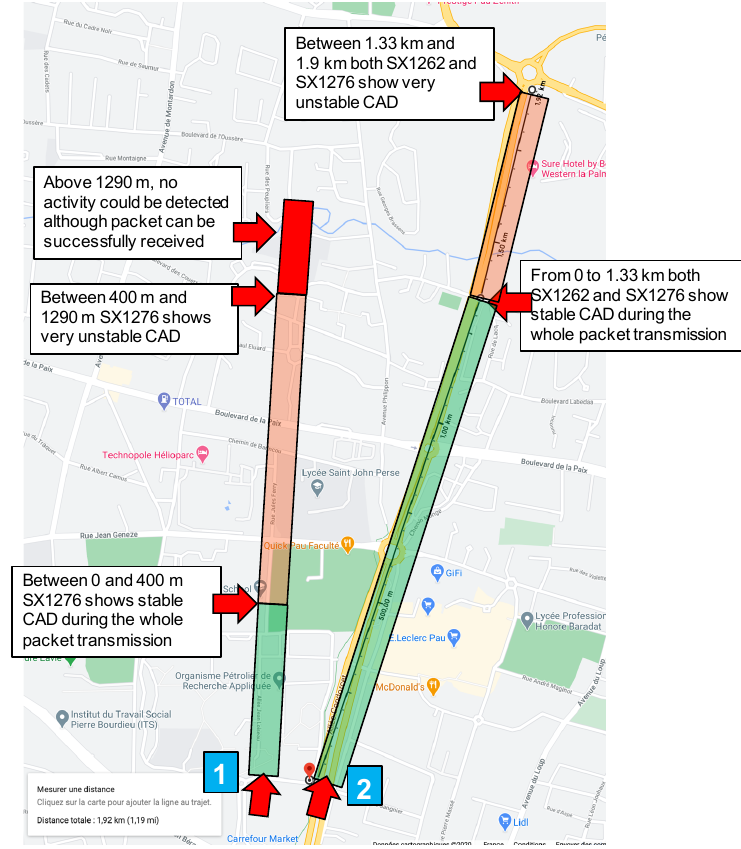
Figure 3. CAD test environment